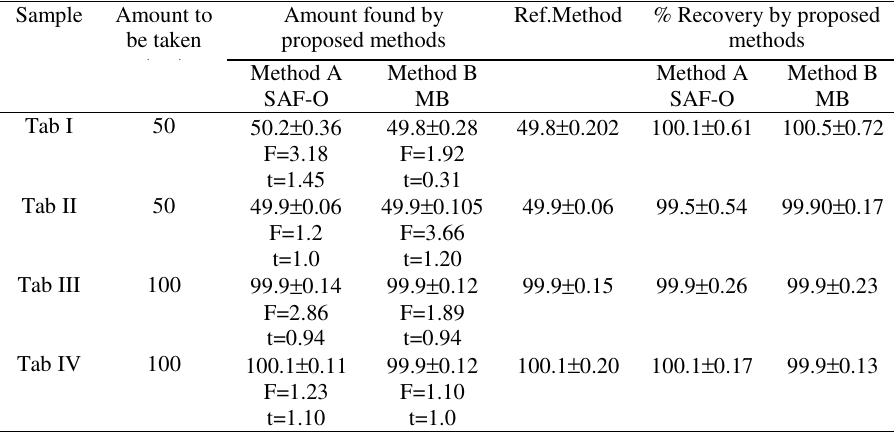
Table 2 Assay of FEX in pharmaceutical